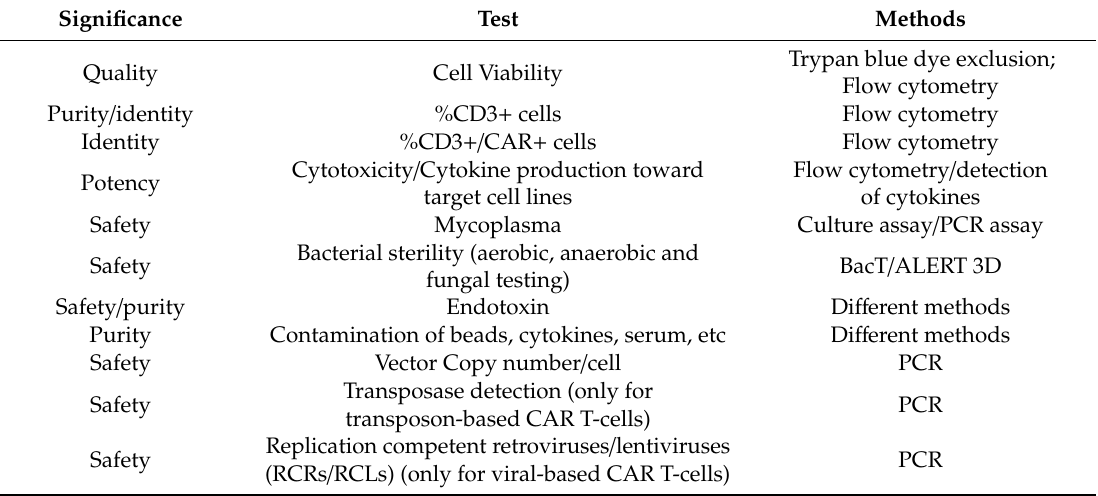
Figure 2. Flow diagram for viral vector and plasmid manufacture. The process of viral production relies on the vector production by stable producer cell lines in the case of retroviral vectors or by transient cell line transfection for lentiviruses. The viral supernatant undergoes concentration, purification and formulation steps. *Benzonase treatment applies only to lentiviral vectors. For plasmid production, initially the E Coli master cell bank of the intended plasmid is produced, from which plasmid replication is promoted by fermentation. After cell lysis, the pre-purification step can be performed by means of filtration, precipitation or solid – liquid separation, followed by the purification and formulation phases. Created with Biorender.com Table 1. Quality control parameters for the release of CAR T-cell products.